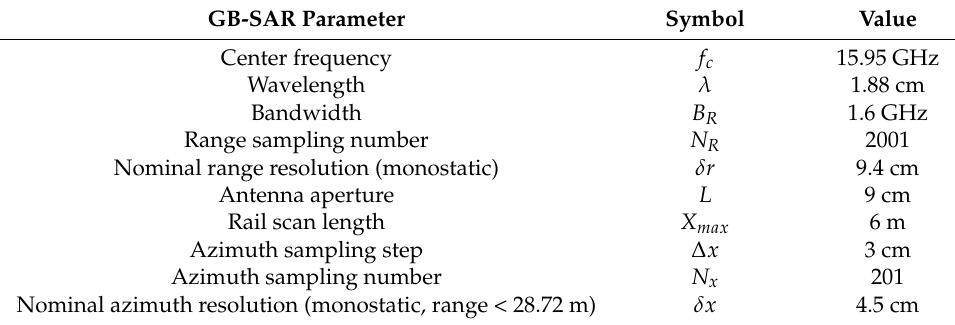
Table 1. System parameters for a bistatic/multistatic GB-SAR